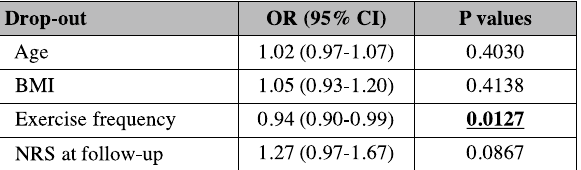
Table 4. Odds ratios for drop-out of the fitness facilities after the 3-month follow-up (n = 20). Exercise frequency was significantly associated with the drop-out (p = 0.0127). BMI: body mass index; NRS: numeric rating scale; OR: odds ratio; CI: confidence interval. Significant differences are indicated in bold.